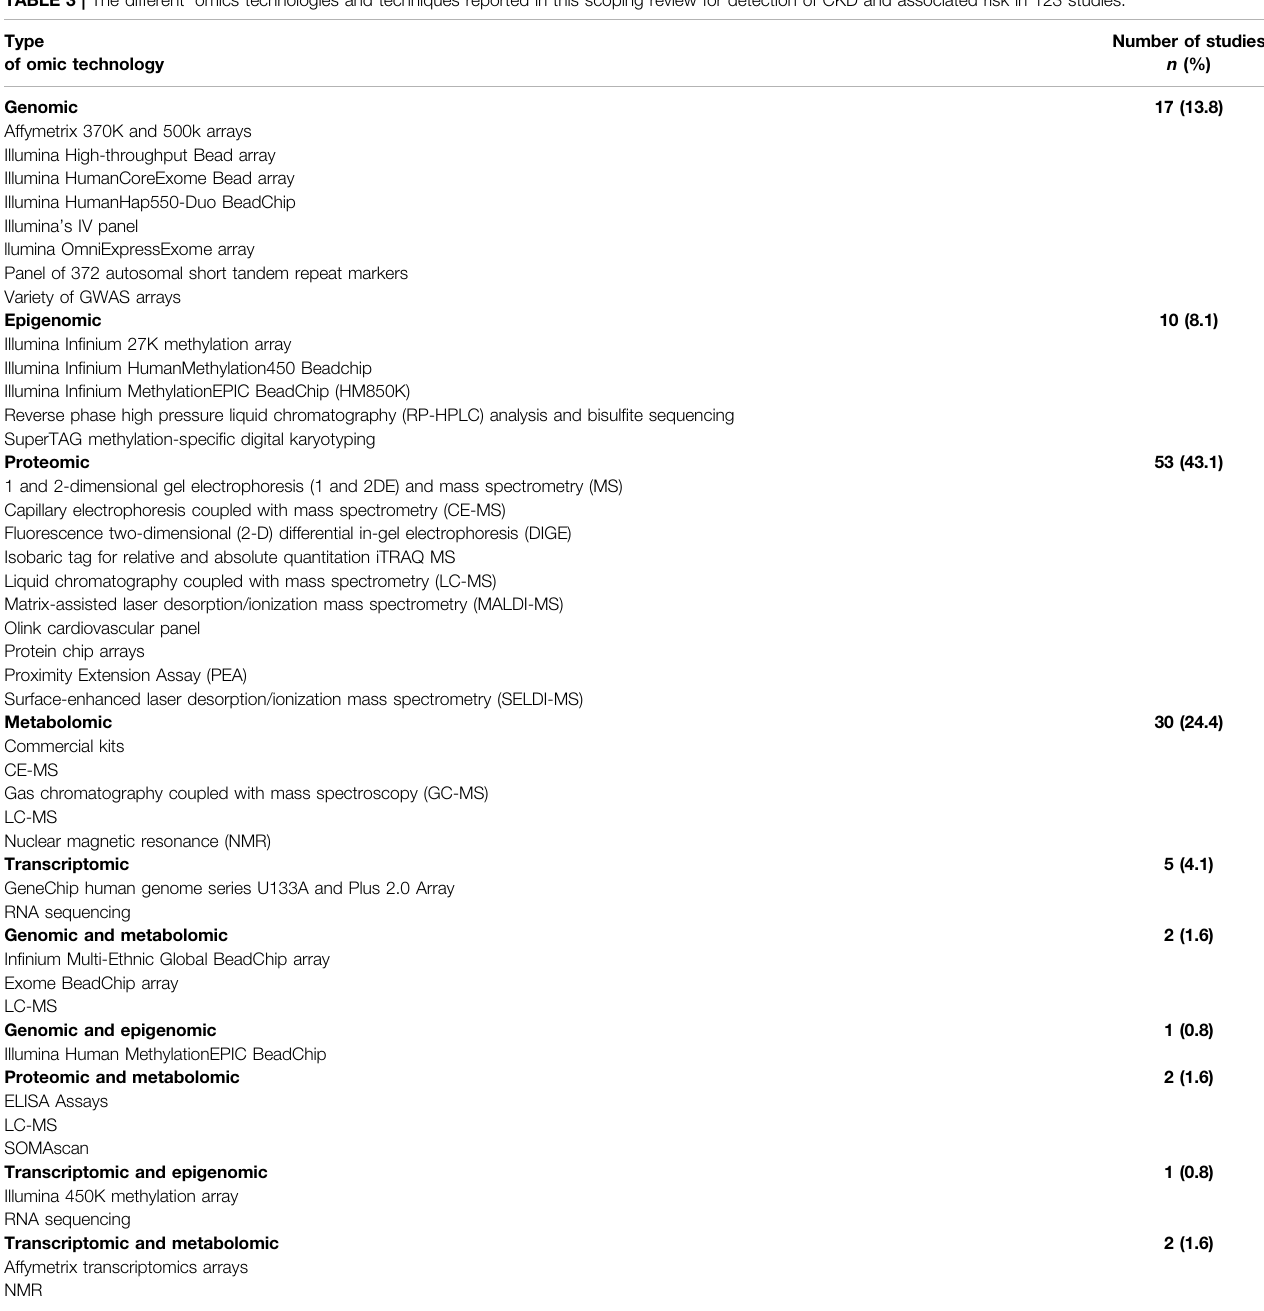
TABLE 3 | The different ‘ omics technologies and techniques reported in this scoping review for detection of CKD and associated risk in 123 studies. Type of omic technology